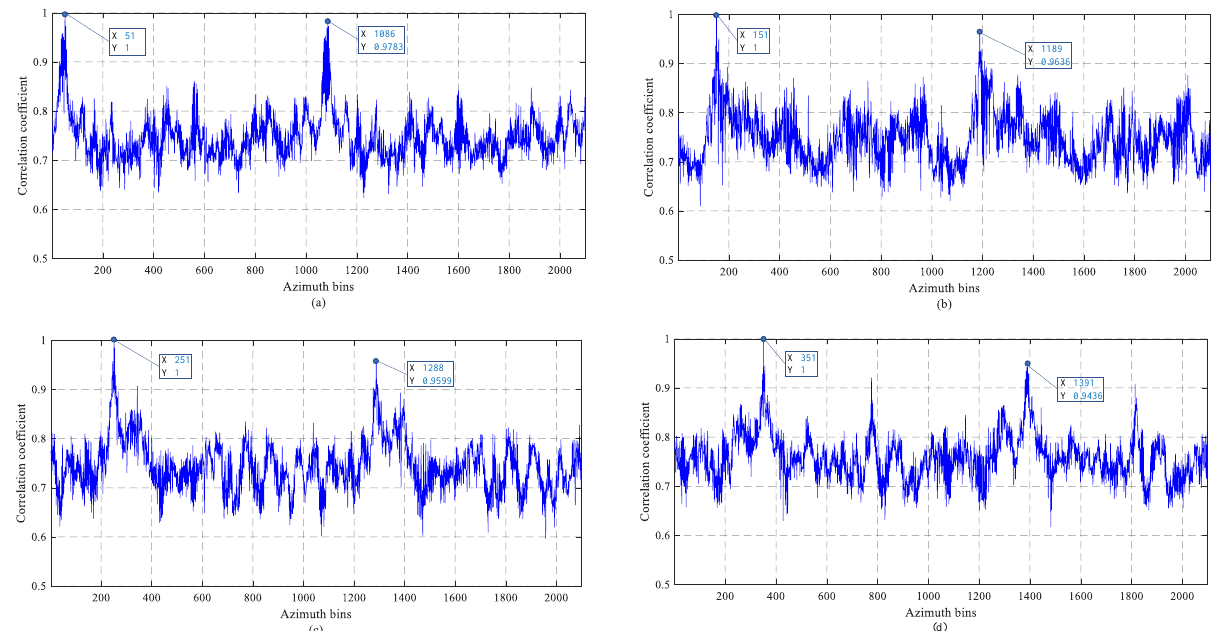
Figure 10. Slide shift when the correlation of the selected echo with all echoes is maximized. ( a ) The 51st echo. ( b ) The 151st echo. ( c ) The 251st echo. ( d ) The 351st echo.